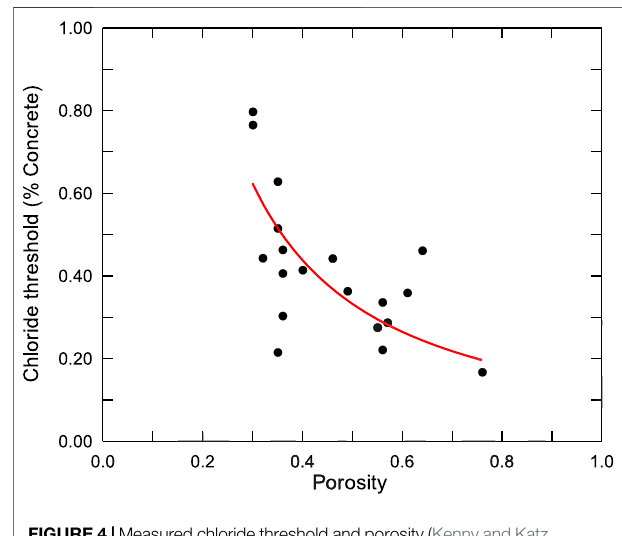
FIGURE 4 | Measured chloride threshold and porosity (Kenny and Katz,